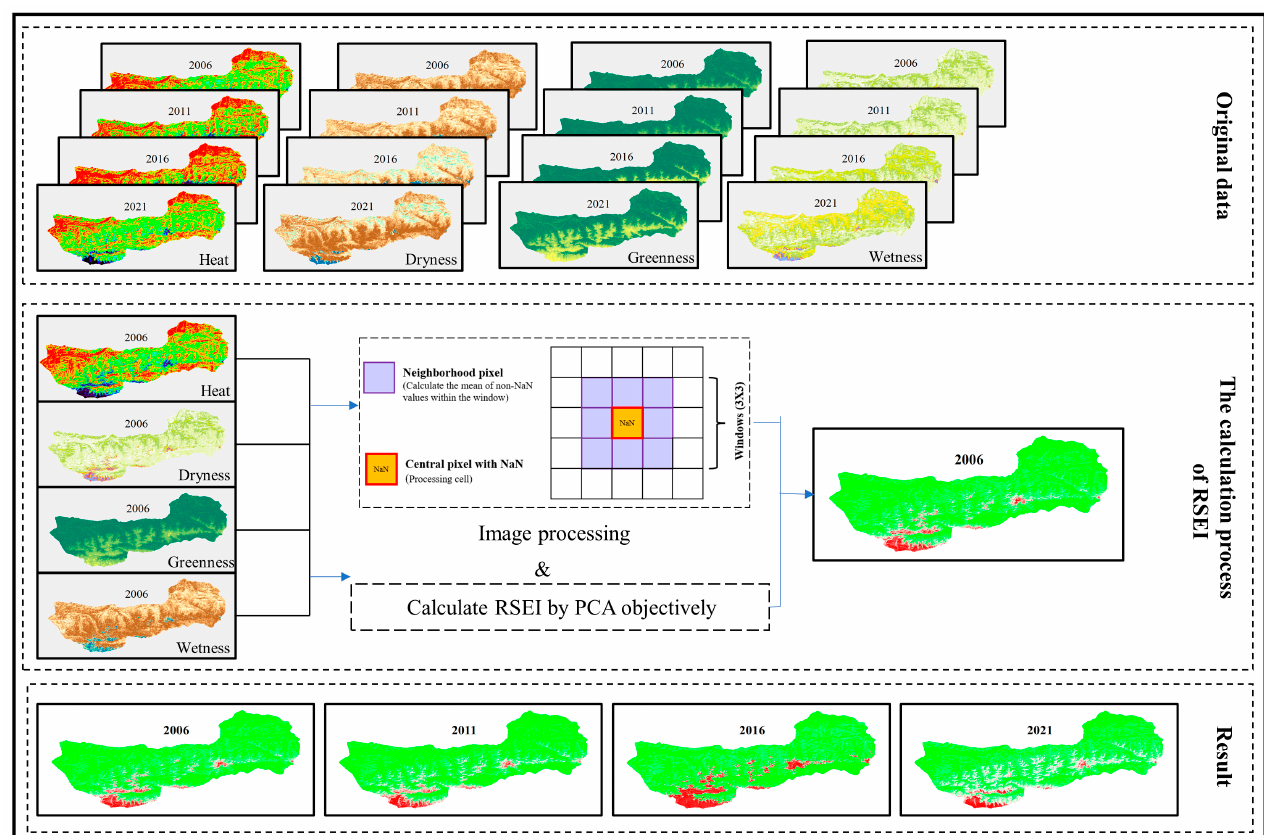
Figure 2. Schematic diagram of Remote Sensing Ecological Environment Index calculation. Table 2. WET, NDVI, NDBSI, LST and RSEI formula calculation and explanation. Index Expression Description